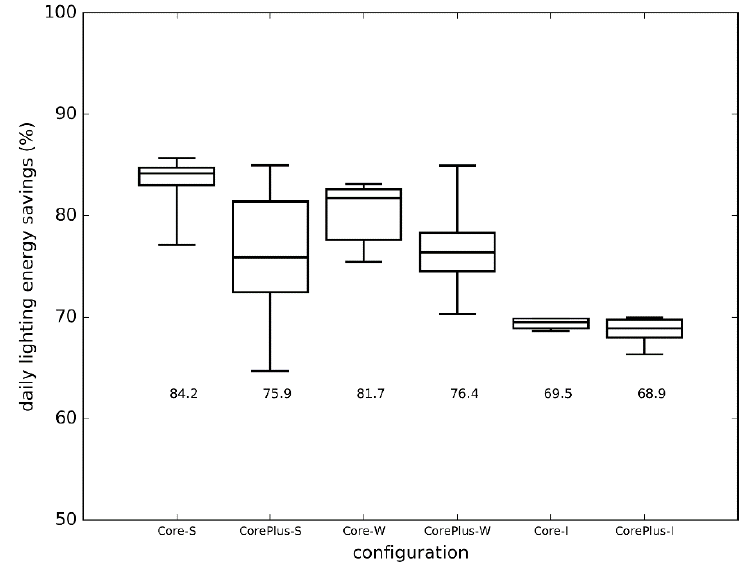
Figure 6. Daily lighting energy savings (%) for each configuration over the test period.